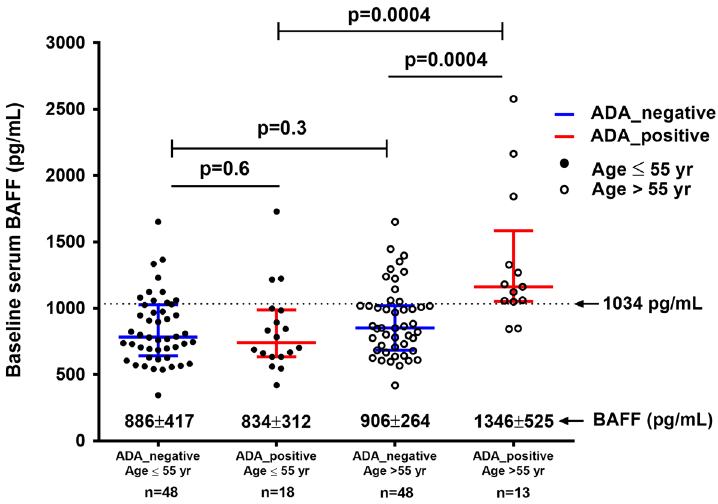
Figure 1. Baseline serum BAFF concentration (mean ± SD) stratified by groups based on ADA status and age (≤ / > 55 years). Dashed line indicated BAFF cut-off for predicting immunogenicity in patients older than 55 years. The results are shown as mean and standard deviation (SD). Comparisons were conducted using the Mann–Whitney U test. p-value < 0.05 was considered statistically